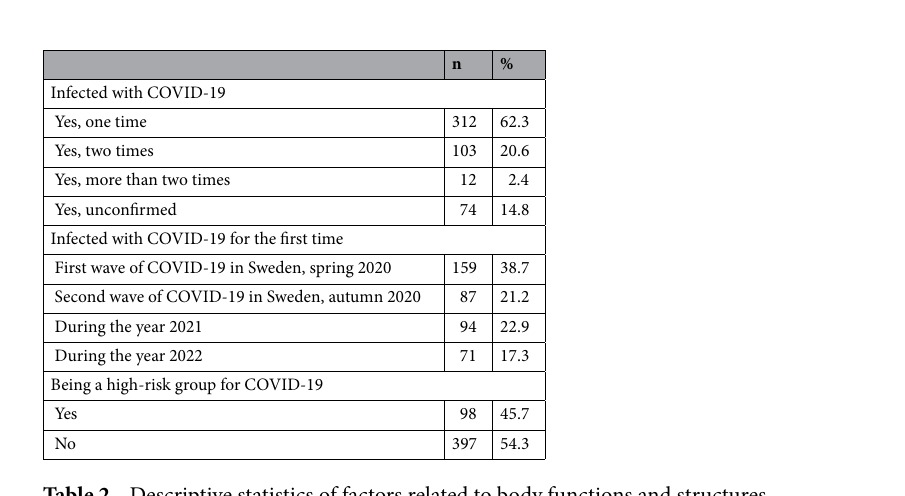
Table 2. Descriptive statistics of factors related to body functions and